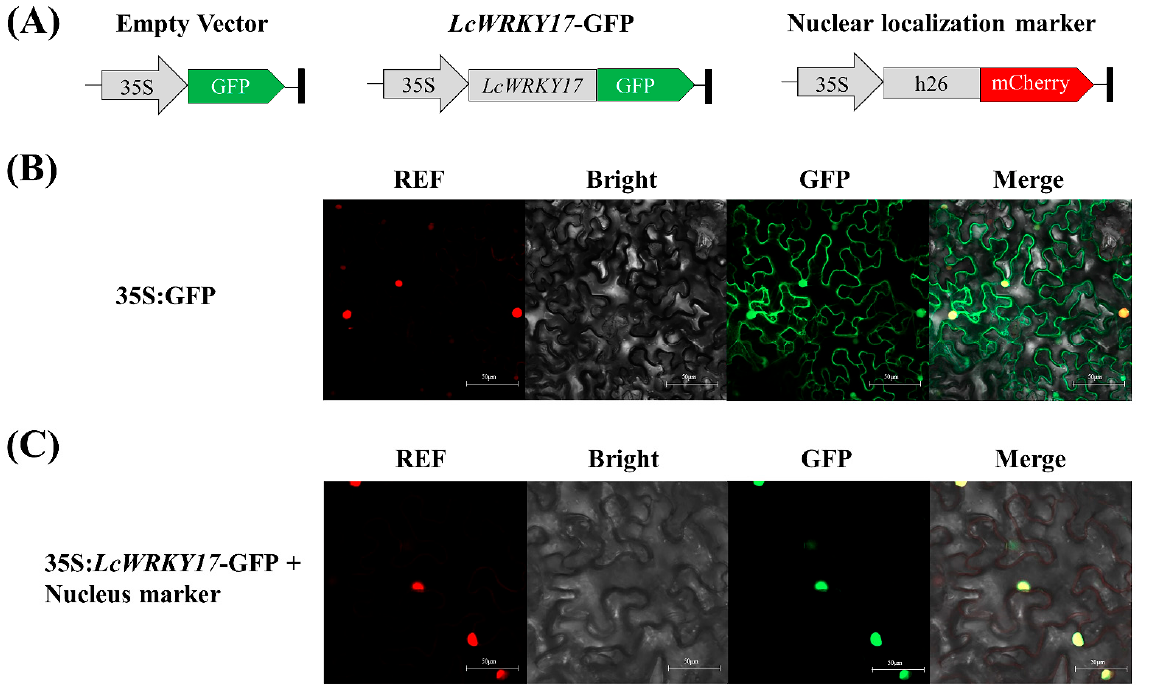
Figure 4. Subcellular localization of LcWRKY17 in N. benthamiana leaves. ( A ) Schematic diagram of vector. ( B ) Empty vector (35S: GFP). ( C ) 35S: LcWRKY17 -GFP and nucleus marker infected four-week large tobacco leaves. Pictures show REF, Bright, GFP, and Merge from left to right. Red represents nuclear localization marker, green represents green fluorescent signal, and yellow represents localization in the nucleus. Scare bar = 50 µm.